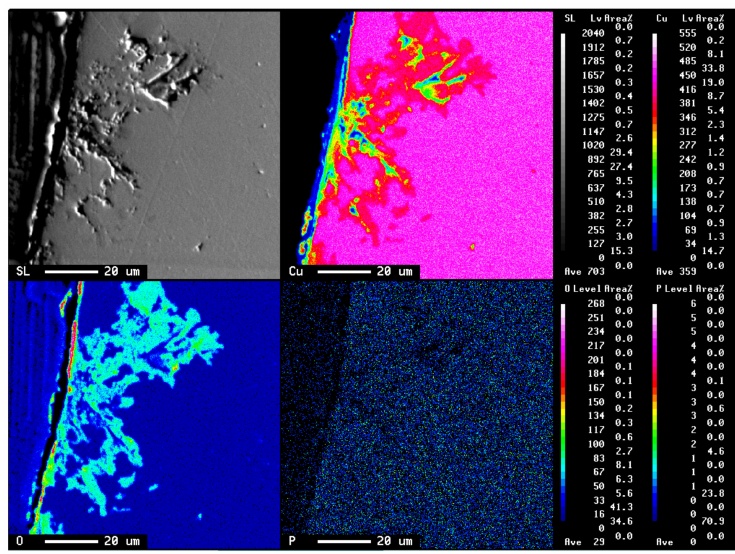
Figure 4. The result of scanning electron microscope (SEM) image of the copper tube after being immersed 15 days in 10 3 ppm Cu(HCOO) 2 ; electron probe micro-analysis (EPMA) led to corresponding elements of copper, oxygen, and phosphorus.